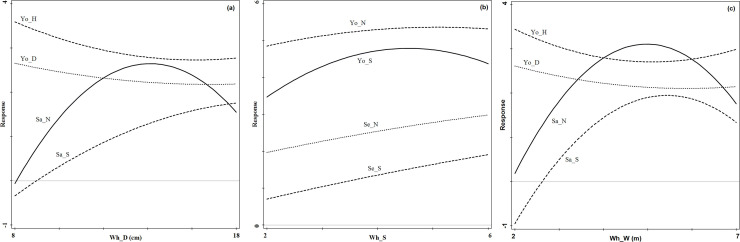
Regeneration response curves to the identified most important structure
indices at the whole stand level (Fig 4A: Wh_D; Fig 4B: Wh_S; Fig 4C:
Wh_W). Se_N and Se_S denote seedling density and tree species richness
index, respectively; Sa_N and Sa_S denote sapling density and tree
species richness index, respectively; Yo_N, Yo_D, Yo_H and Yo_S denote
young tree density, diameter at breast height, tree height and tree
species richness index, respectively.